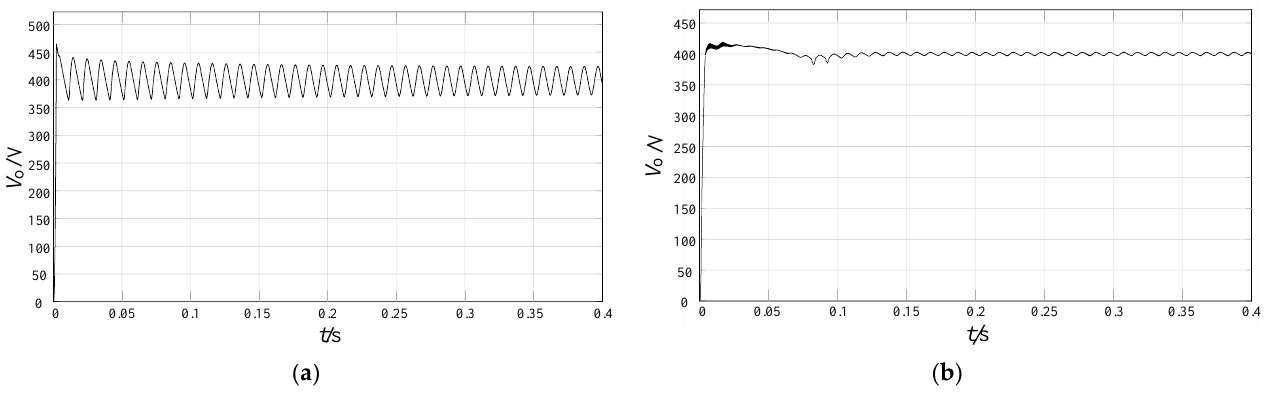
Figure 13. Output voltage waveforms of the bridgeless PFC converter: ( a ) bidirectional buck/boost converter is not contained; ( b ) bidirectional buck/boost converter is contained.